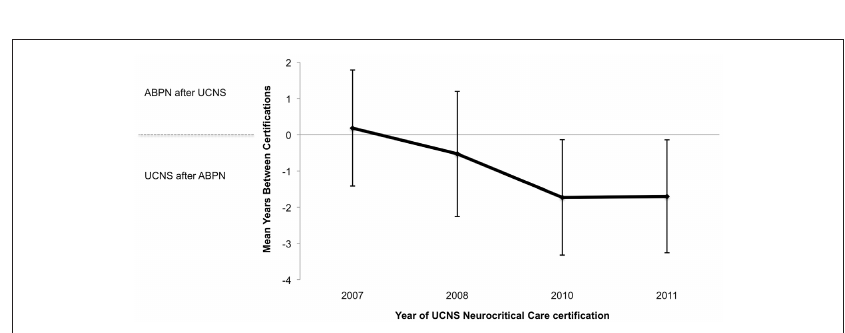
Figure A1 | Cumulative percentage of uCNS diplomates who also hold ABPN Vascular Neurology certification by year of uCNS